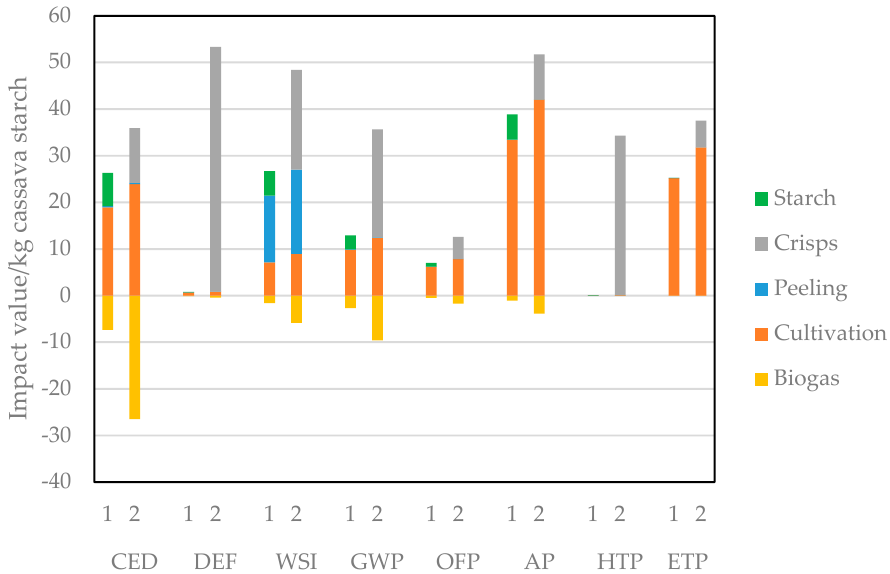
Figure 3. Environmental impacts of industrial (1) and advanced (2) cassava processing per kg of starch output; cumulated energy demand (CED) in MJ, deforestation (DEF) in 5 × 10 − 3 m 2 , water stress index (WSI) in 5 × 10 − 3 m 3 , global warming potential (GWP) in 10 − 1 kg CO 2 -eq, ozone formation potential (OFP) in 10 − 3 kg NMVOC-eq, acidification potential (AP) in 10 − 3 mol H + , human toxicity potential (HTP) in 10 − 2 kg 1,4-DB-eq, and ecotoxicity potential (ETP) in 5 × 10 − 2 kg 1,4-DB-eq. 0.01 m 2 / FU, 2.6 kg CO 2 -eq. / FU, 0.01 kg NMVOC-eq. / FU and 0.01 m 3 / FU, respectively. The